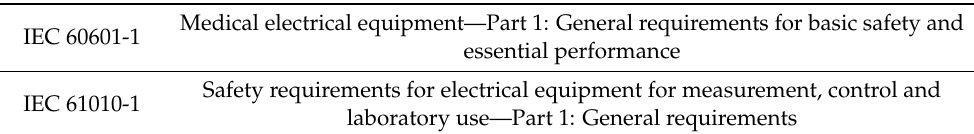
Table 1. ME Safety Standard & Electrical Safety Standard.